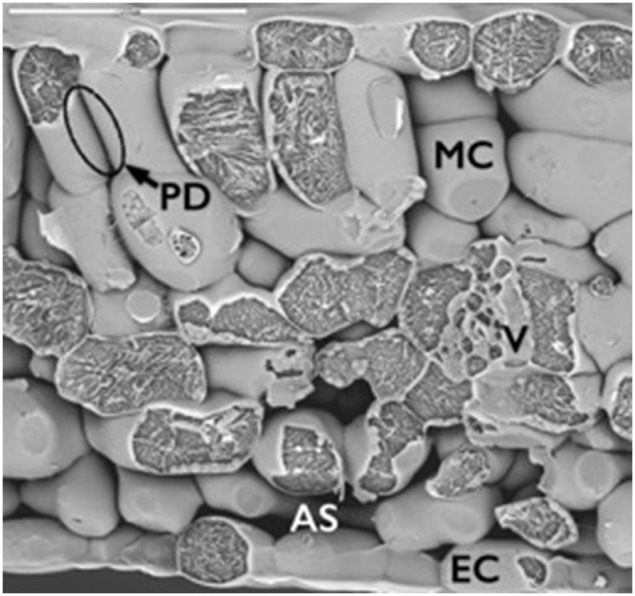
Freeze–fracture low-temperature scanning electron micrograph of a transversal section from a Beta vulgaris leaf. This leaf transversal section gives three-dimensional information on the internal structure of the leaf. Apoplastic space (AS in white letters) surrounds mesophyll (MC) and epidermal cells (EC). The image also shows the presence of plasmodesmata (PD) that communicate neighboring mesophyll cells.